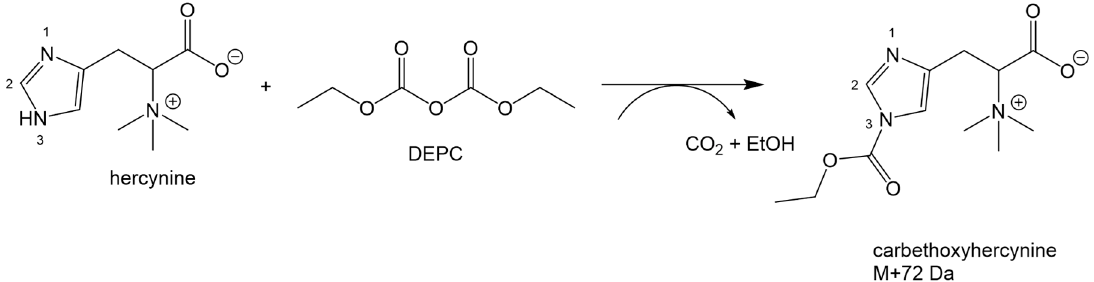
Figure 3. Derivatization of ERY by DEPC to form carbethoxyhercynine.